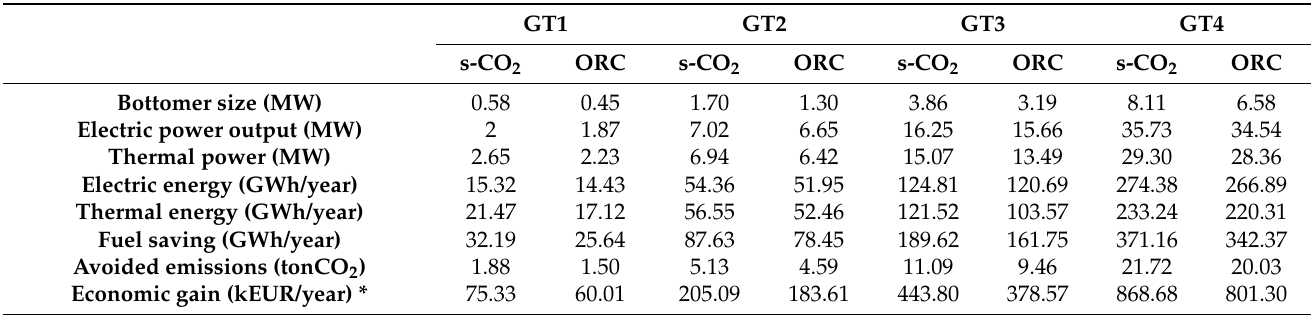
* Reference case results—Figure 12 demand profile and C CO 2 = 40